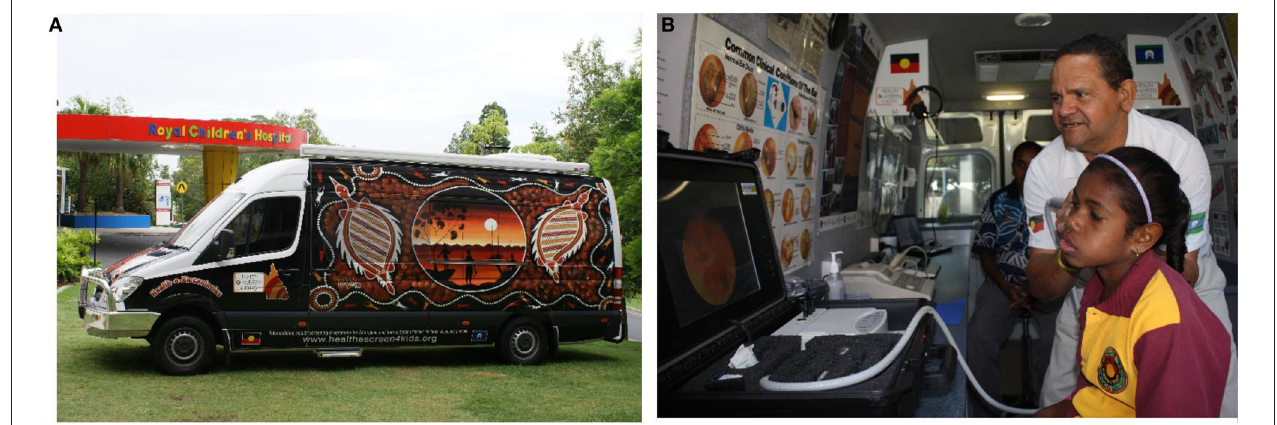
FIGURE 5 | (A) Mobile screening van used for surveillance of Aboriginal and Torres Strait Islander children at risk of ear disease and (B) child being screened by an experienced Aboriginal Health Worker.